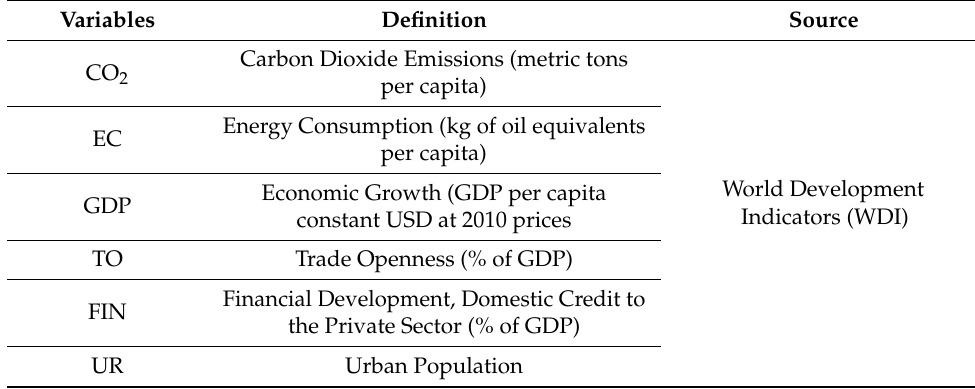
Table 1. Variables used in the